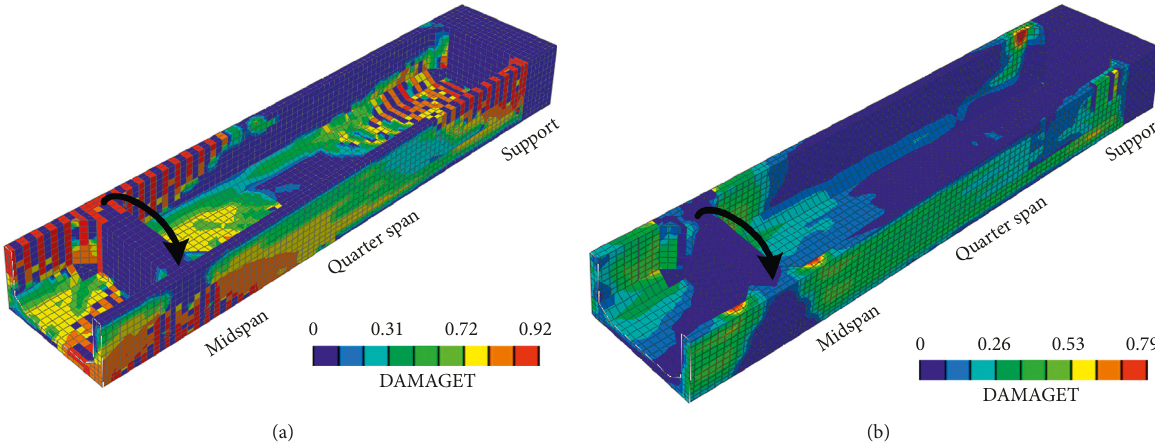
Figure 12: The simulated crack patterns and failure modes: (a) distribution of tensile damage at a load level of 80% ultimate torque and (b) distribution of compressive damage at ultimate load level. “FC” means flexural cracking, “YL” means yielding of longitudinal bars, and “YS” means yielding of stirrups.